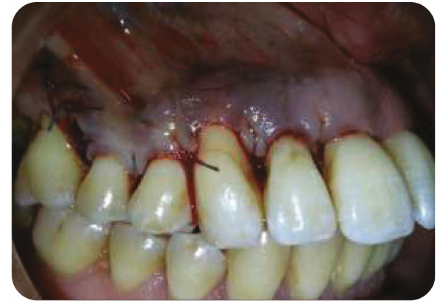
Figure 9: Operative site after